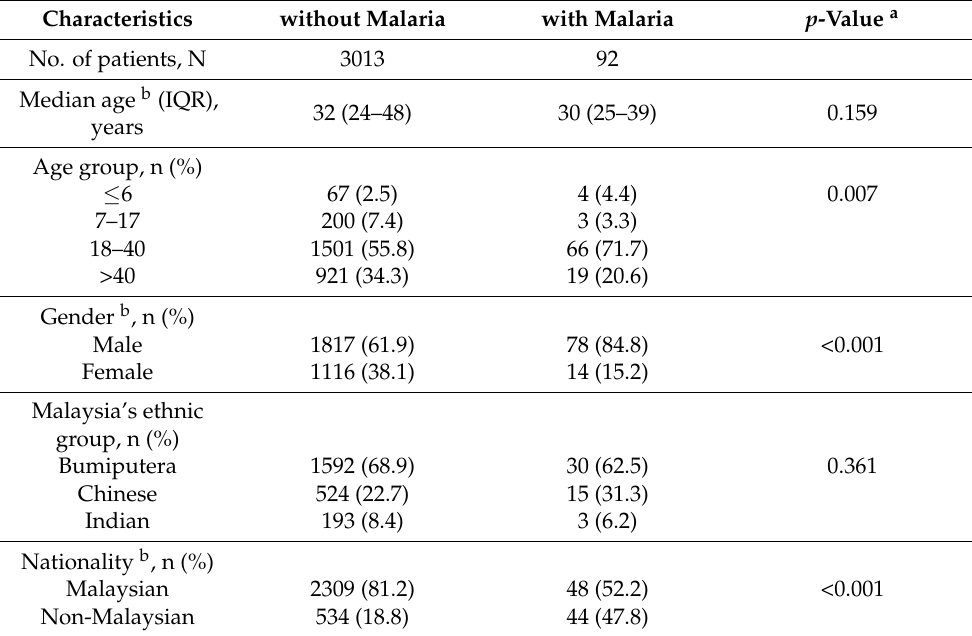
Table 1. Demographic characteristic of patients screened at University Hospital of the